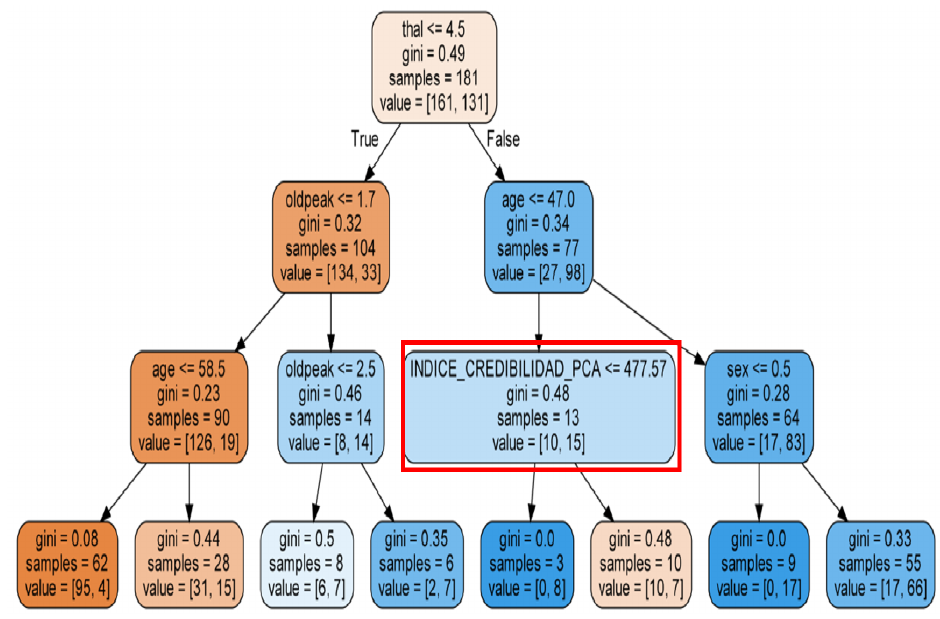
Figure 12. RF graph generating BPA, reflecting the importance of CI.